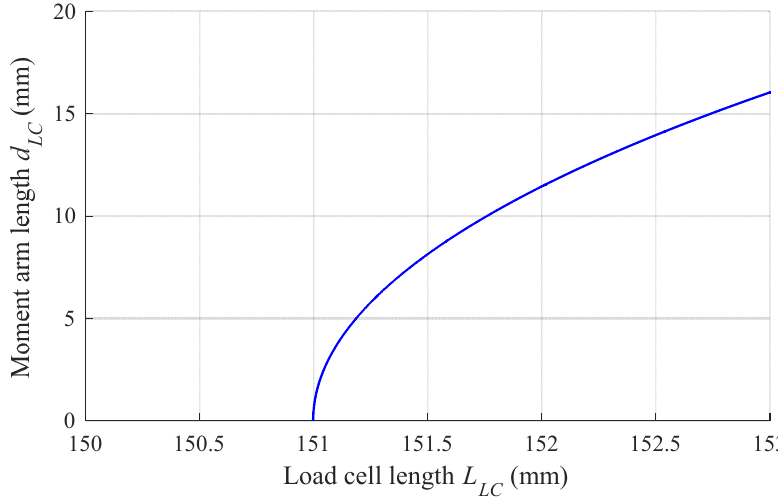
Figure 6. Influence of the load cell length L LC on the moment arm length d LC : L L = 50, d L = 0, L B = 200 and d B = 20 mm.